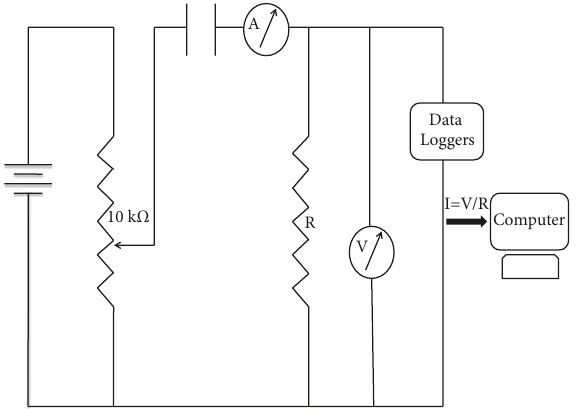
Figure 16: Experimental set-up of standard Wagner polarization technique.